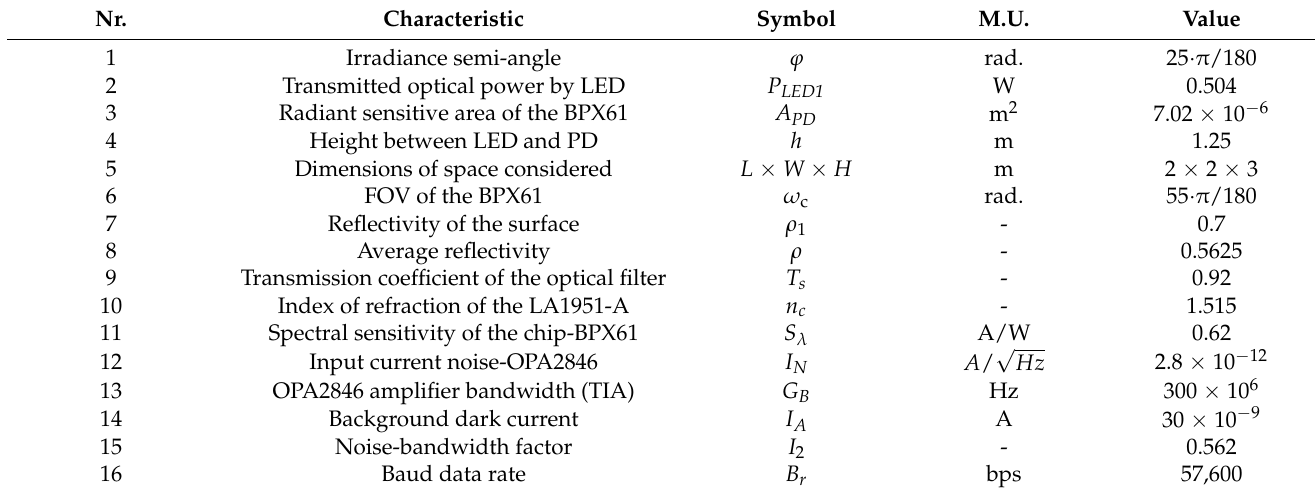
Table 3. Characteristics considered for channel model